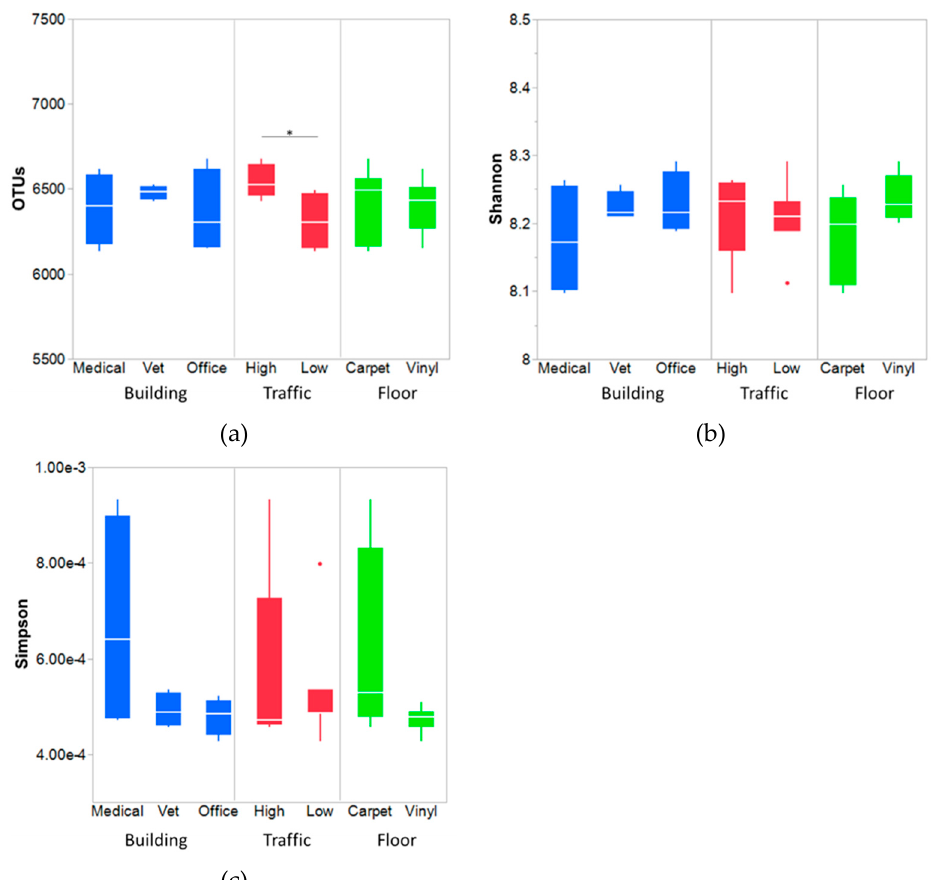
Figure 2. Comparison of OTUs ( a ), Shannon diversity index ( b ), and Simpson diversity index ( c ) between the floor, traffic, and building types. The box-and-whisker plot indicates the median line, 1st and 3rd quartiles. The error bars below and above of a box indicate the 10th and 90th percentiles, respectively. Outliers are shown as filled circles. * Significant difference of OTUs between the high and low traffic areas was observed ( p < 0.05).